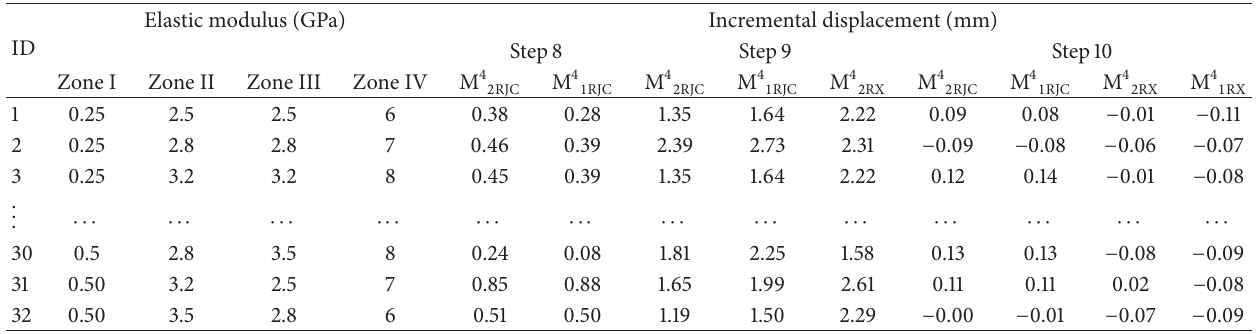
Table 4: The incremental displacements of the monitoring points in the orthogonal experimental design.